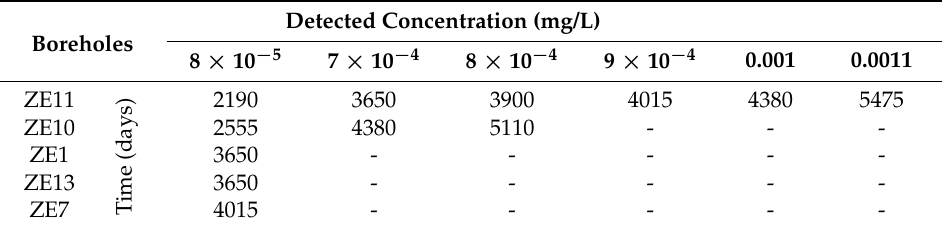
Table 5. Time of appearance of dissolved benzene in boreholes close to the Anador